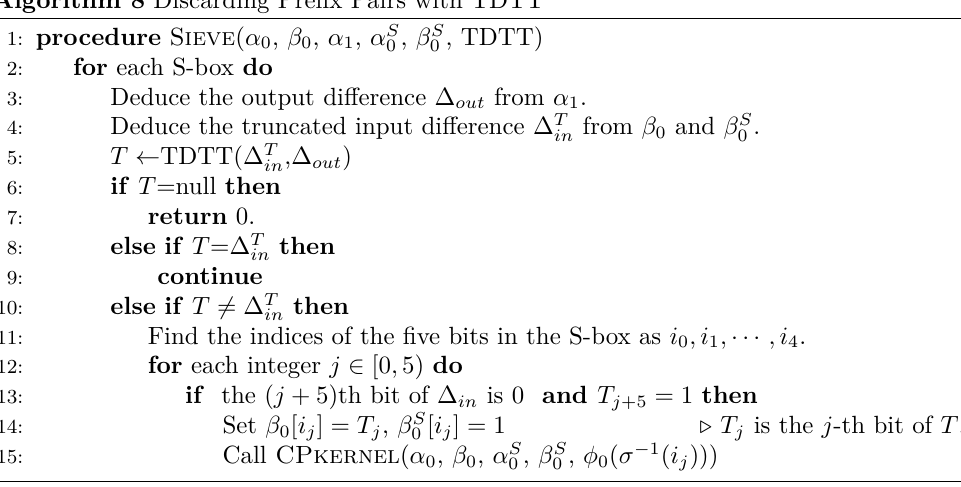
Algorithm 8 Discarding Prefix Pairs with